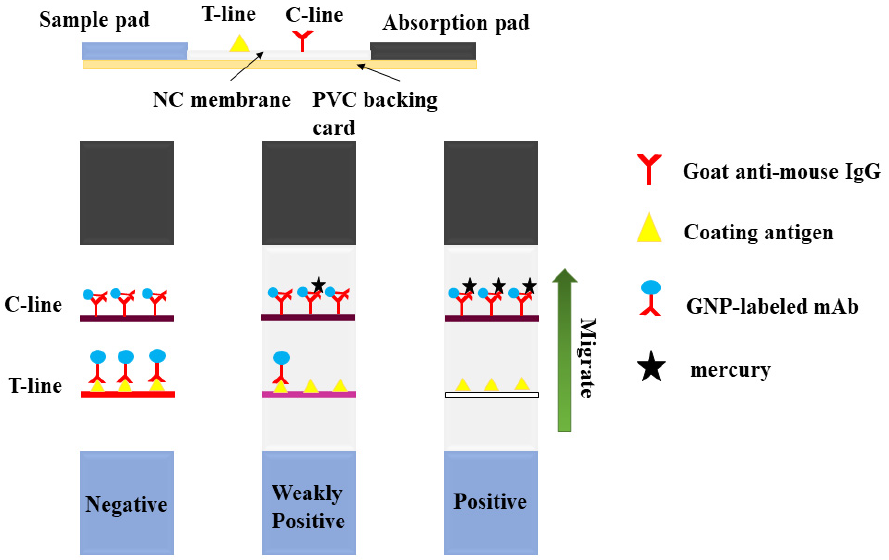
Figure 2. Composition of the test strip and the schematic for sample detection.